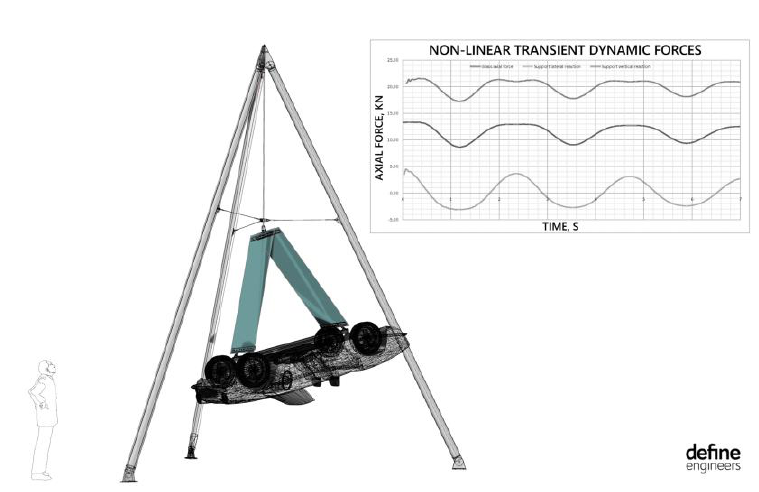
Fig. 11 Dynamic forces diagram (©